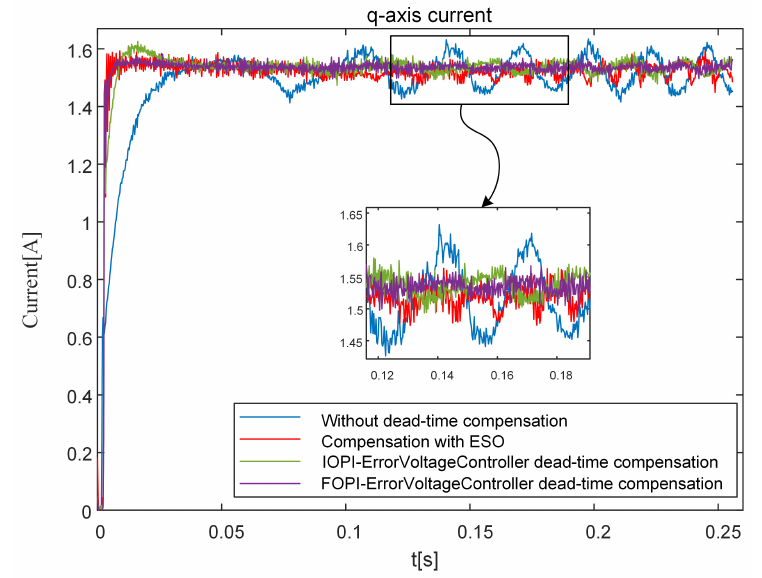
Figure 25. Comparison of I q current